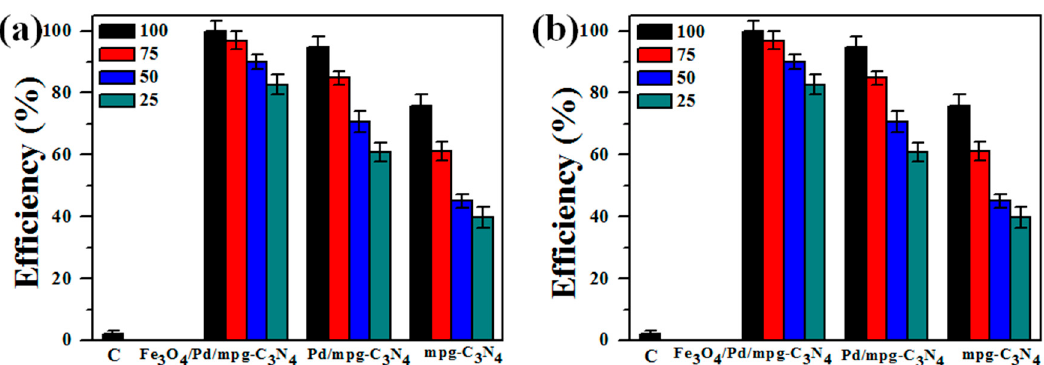
Figure 4. Bacterial degradation e ffi ciency of ( a ) E. coli and ( b ) S. aureus with 10 8 CFU / mL. The e ffi ciency of mpg-C 3 N 4 , Pd / mpg-C 3 N 4 hybrids, and Fe 3 O 4 / Pd / mpg-C 3 N 4 nanocomposites was estimated at di ff erent concentrations (25, 50, 75, and 100 µ g / mL) after 2 h of solar light irradiation and magnetic separation. The symbol C represents control sample.